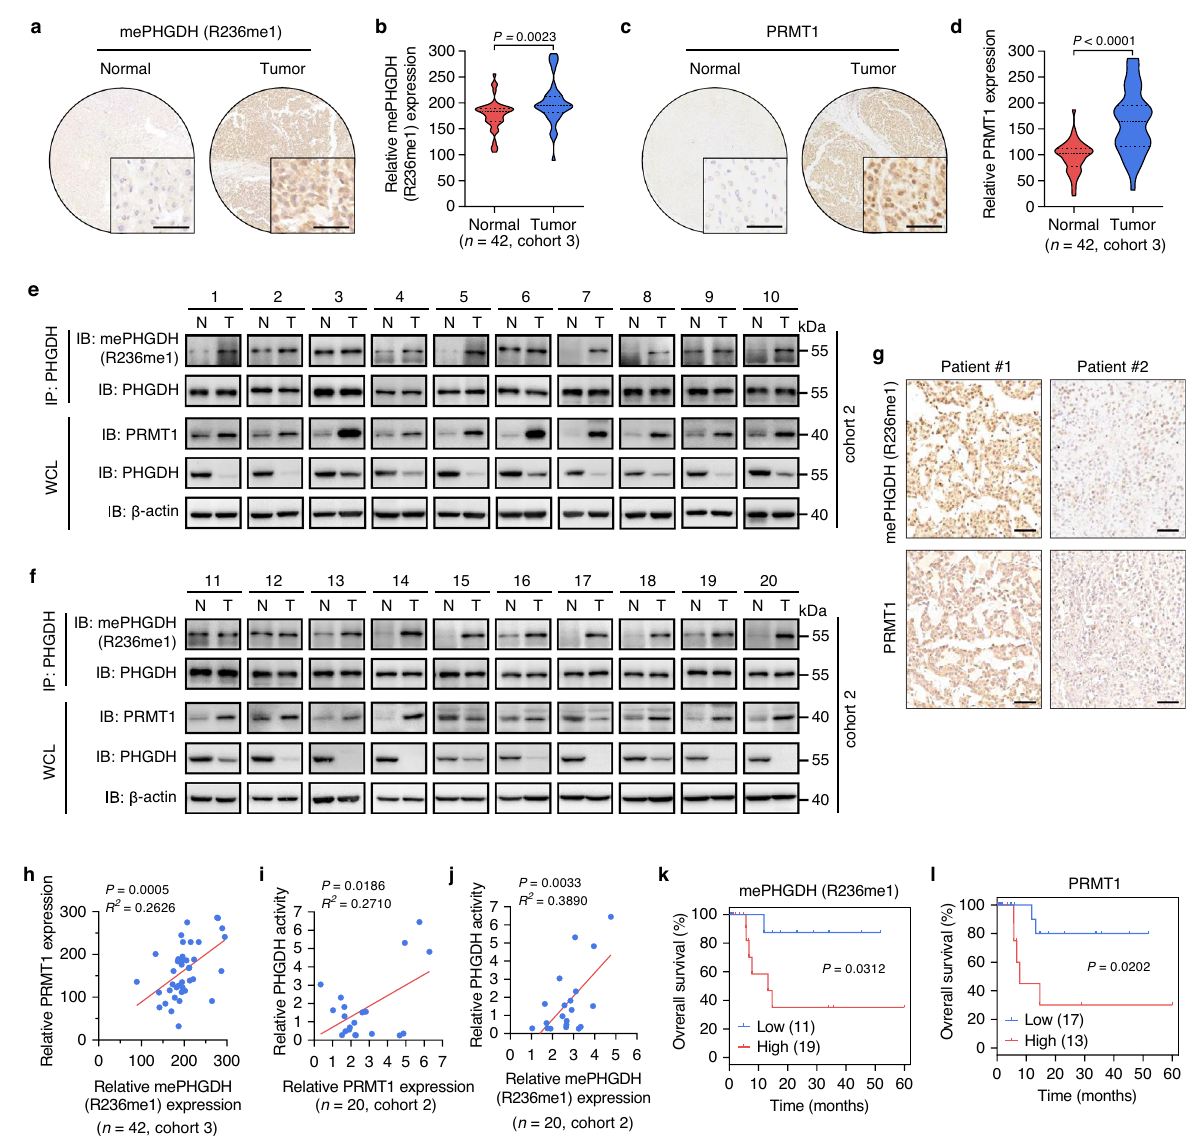
Fig. 6 | PHGDH is hypermethylated at R236 by PRMT1 in human HCC Tissues. a , b Representative images ( a ) and quantitative analysis ( b ) of IHC staining using mePHGDH (R236me1) antibody in HCC tissues and paired normal tissues ( n =42samples,cohort3).Scalebars,50 μ m.Statisticalanalysiswasperformedusing the paired two-tailed Student ’ s t test. c , d Representative images ( c ) and quantitative analysis ( d ) of IHC staining for PRMT1 in HCC tissues and paired normal tissues ( n =42samples,cohort3).Scalebars,50 μ m.Statisticalanalysiswasperformedusing the paired two-tailed Student ’ s t-test. e, f IP and immunoblotting analysis with indi- catedantibodiesin20HCCtissues(T)andpairednormaltissues(N).WCL,wholecell lysates.R236mono-methylationofimmunoprecipitatedPHGDHwasdeterminedand normalized to PHGDH protein ( n =20, cohort 2). g Representative images of IHC